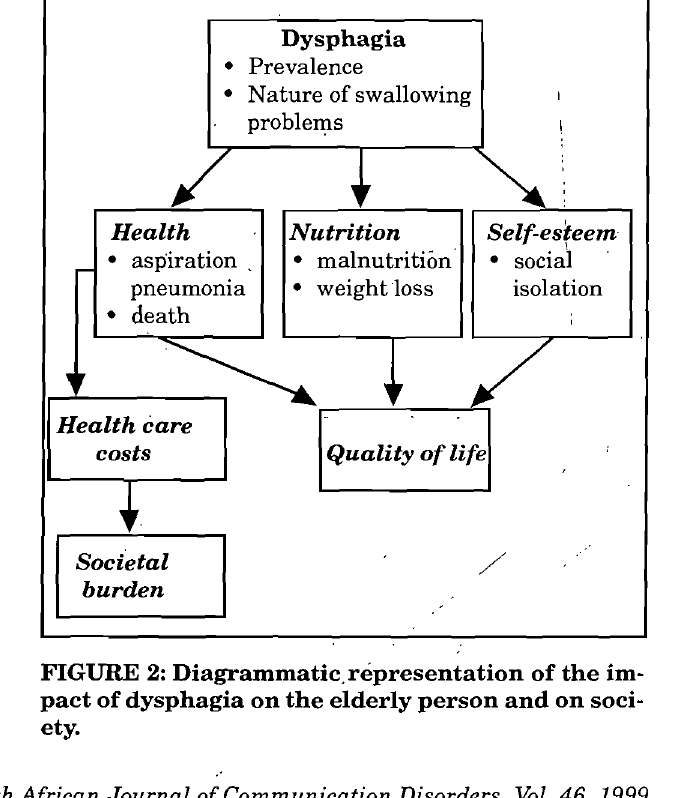
FIGURE 2: Diagrammatic,representation of the im pact of dysphagia on the elderly person and on soci